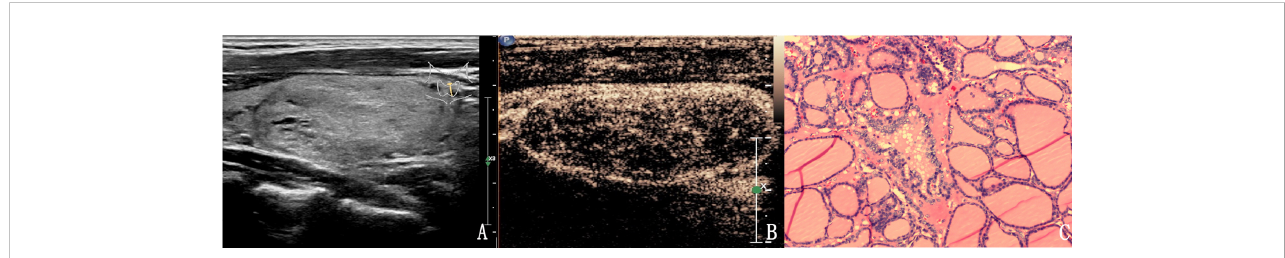
FIGURE 2 The case of a 46-year-old woman with a 37.3 × 18.1 × 24.7 mm solid hyper-echoic nodule in the left lobe of the thyroid. (A) Conventional two- dimensional image showed that the nodule had one malignant indicator (solid) and was classi fi ed with a TI-RADS score of 3. (B) Ultrasound contrast image showing ring enhancement. The modi fi ed version of TI-RADS combined with CEUS returned a score of 2 and the patient was diagnosed with a benign nodule. (C) Pathological image of the lesion, a nodular